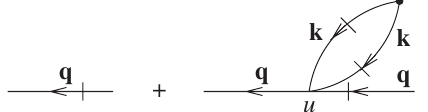
FIG. 2. One-loop propagator renormalization. The loop diagram depicts the first-order correction to the self-energy or two-point vertex function Γ ~ ψψ (cid:2) ð q ; ω Þ